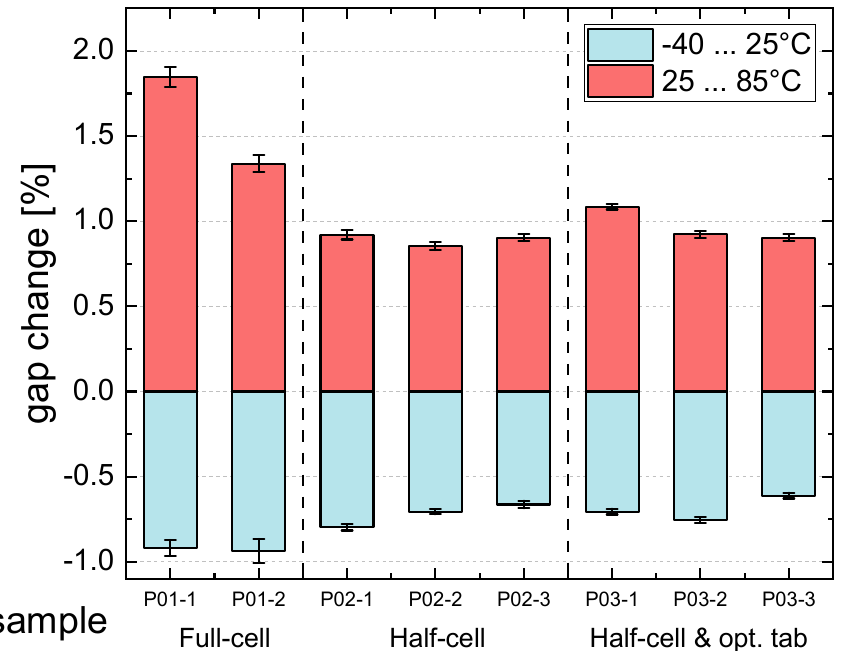
Figure 11. Gap change between the 4-busbar solar cells laminated into mini-modules with 3 full-size equivalent solar cells and fabricated with the same bill of materials. The half-cell and full-cell groups differ only in the cell size, and the half cell and half cell with optimized tab differ only in tab width (adapted from [8]).